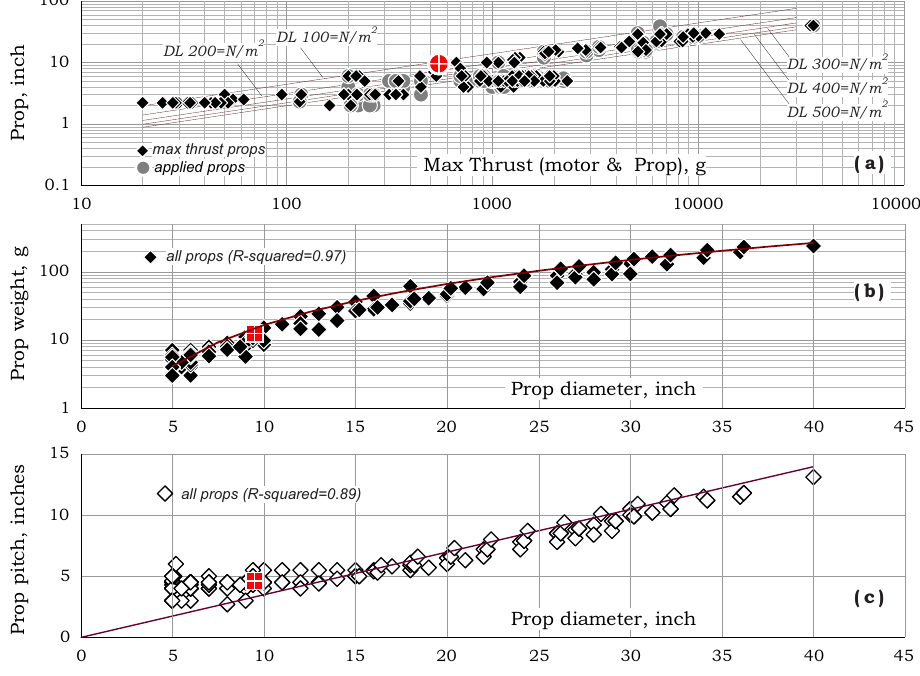
Figure 1. Propeller diameter, weight and pitch design trends,